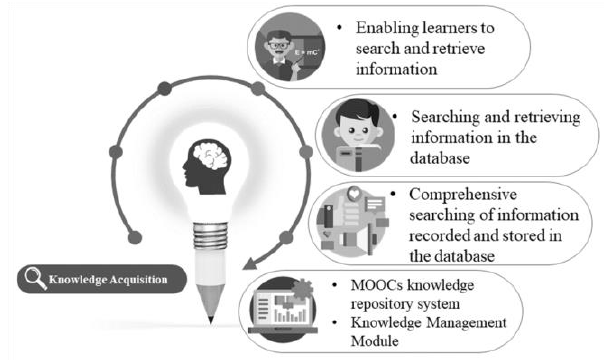
Fig. 6. Knowledge Acquisition